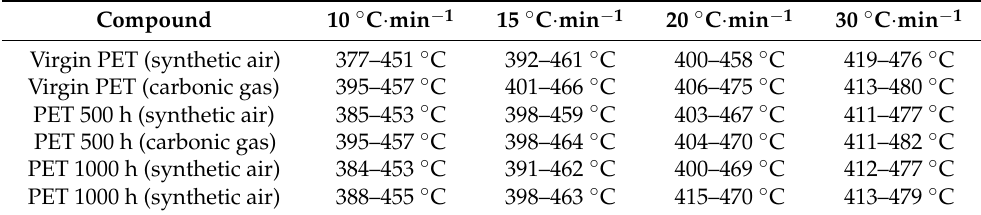
Figure 9. Activation energy versus conversion degree ( α ) from three isoconversional methods. Table 1. Temperature intervals (°C) of the first stage of thermal decomposition.